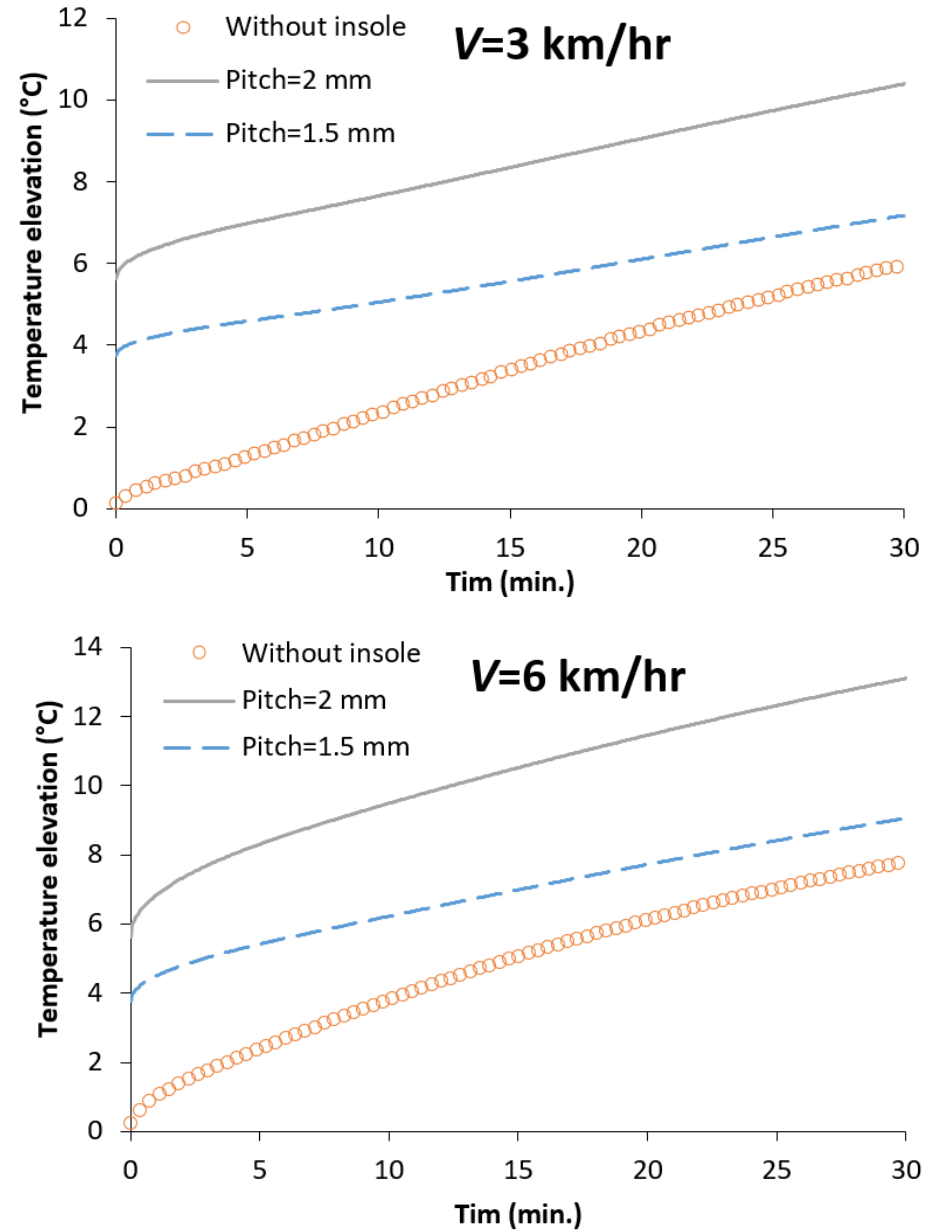
Figure 8. The foot sole temperature during shod gait at 3 and 6 km/h, using two porous turf-like insole designs with pitch of 2 mm and 1.5 mm and comparing with no insole condition.